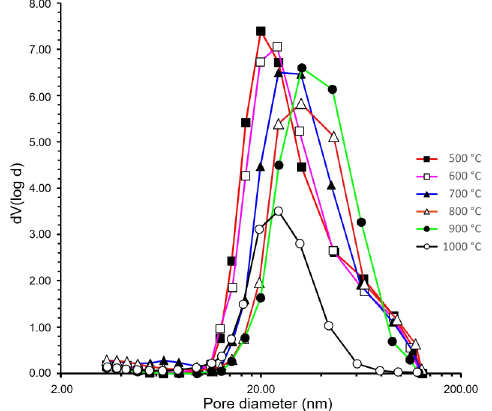
Figure 4. Pore size distribution curves of heat-treated samples calculated using the BJH method.